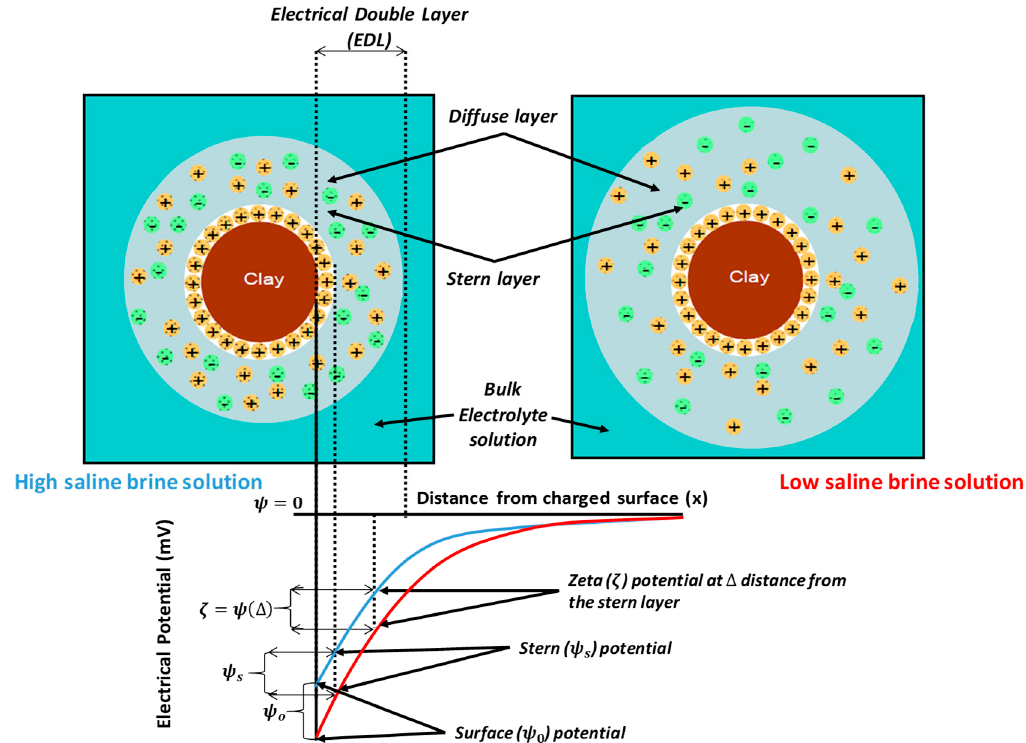
Figure 11. A schematic illustration of the EDL expansion in sandstone reservoirs for original high saline condition ( left ) and low saline condition ( right ) with corresponding changes in surface charge distribution shown ( bottom ). The blue and red lines represent the electrical potential distribution under high saline and low saline brine, respectively (adapted from Awolayo et al. [62]).